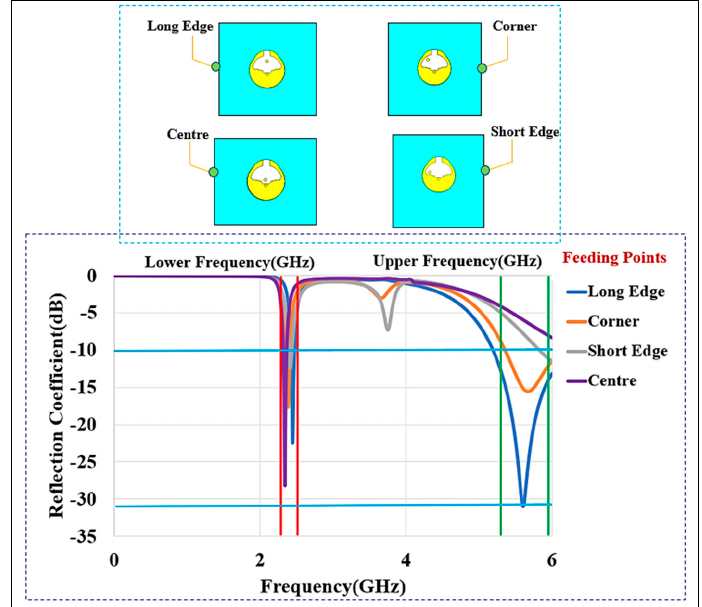
Figure 8. The reflection coefficient (S 11 ) of the BSA for different feed locations (lower band markers are at 2.22 to 2.8 GHz; upper band markers are at 5.0 to 5.9 GHz).